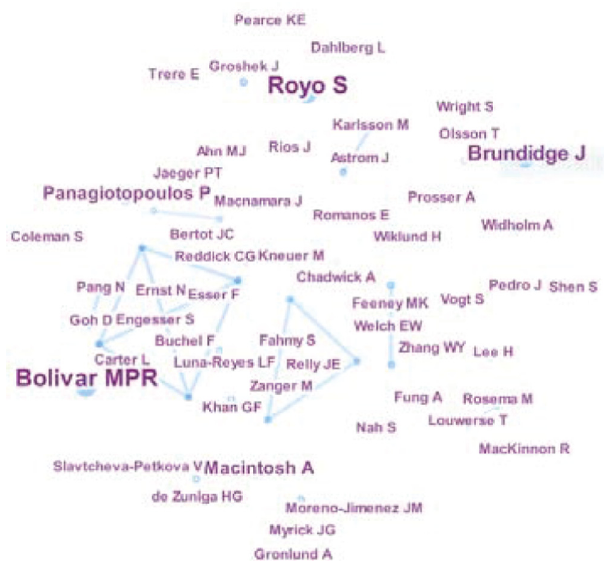
Figure 4. Cooperation